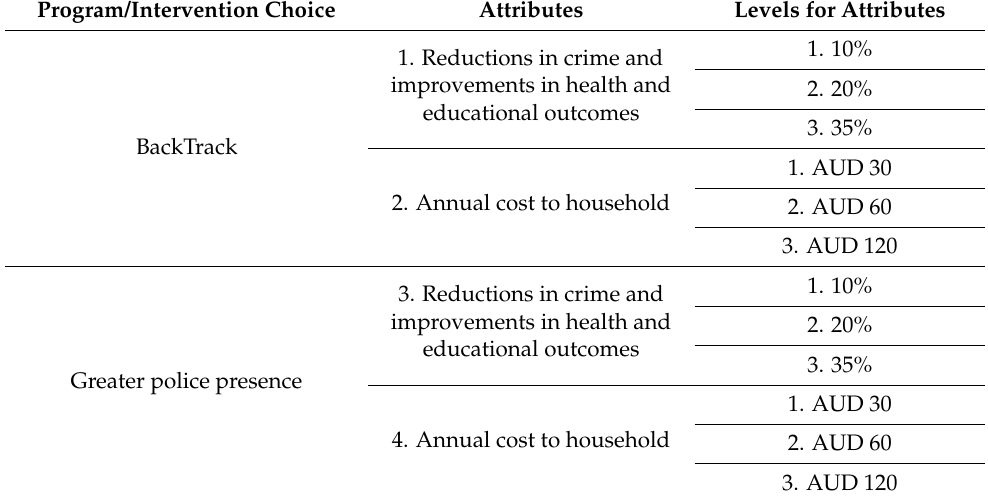
Table 1. DCE choices, attributes, and